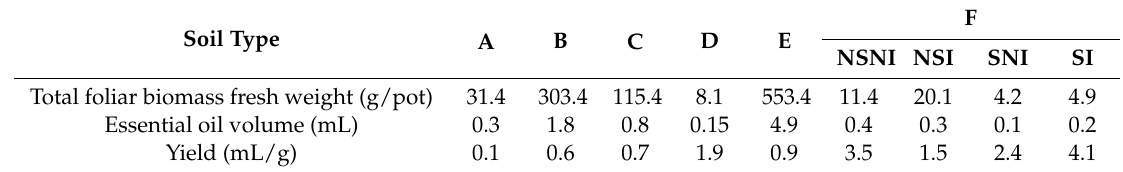
F NSNI NSI SNI SI